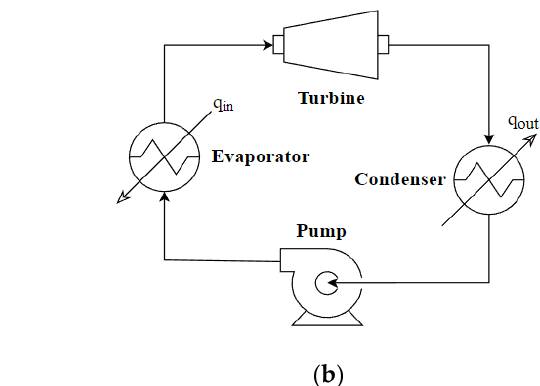
Figure 1. Schematic of CO 2 power cycles. ( a ) Brayton cycle. ( b ) Rankine cycle.